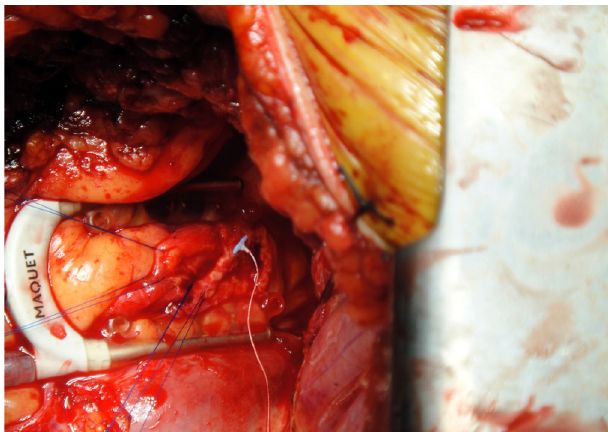
3 - PDA stabilization and shunt in - The PDA is stabilized with the use of the Maquet-Acrobat and a 1,5 flow-thru shunt is